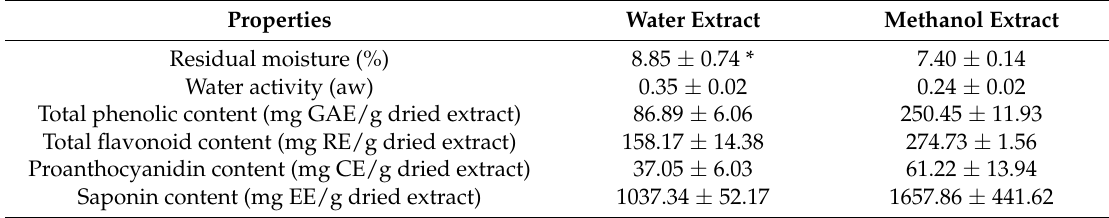
Table 1. Physicochemical properties of powdered P. amarus water and methanol extracts. Properties